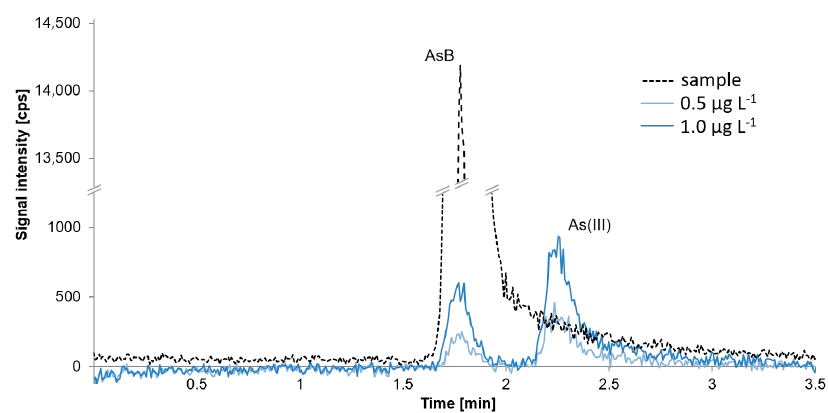
Figure 4. Chromatogram presenting selected fish sample with the concentration of AsB equal to 4.5 µg g − 1 and standards with the concentration of 0.5 µg L − 1 and 1 µg L − 1 obtained using 20 mmol L − 1 of ammonium carbonate as mobile phase.